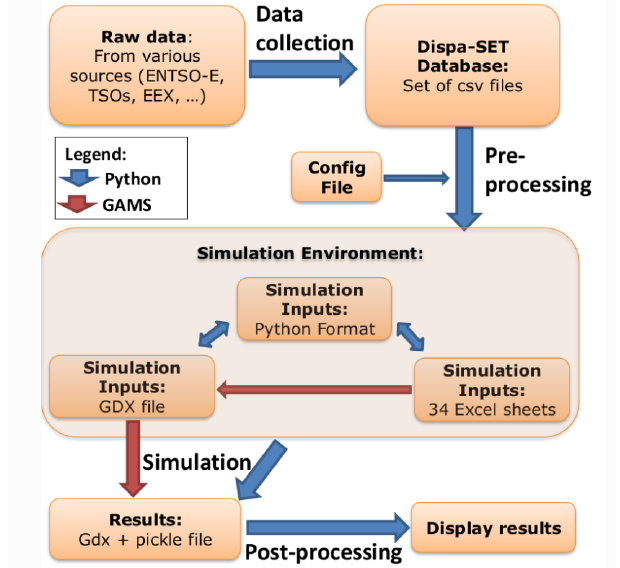
Figure 2. Flow chart of the implementation and processing steps